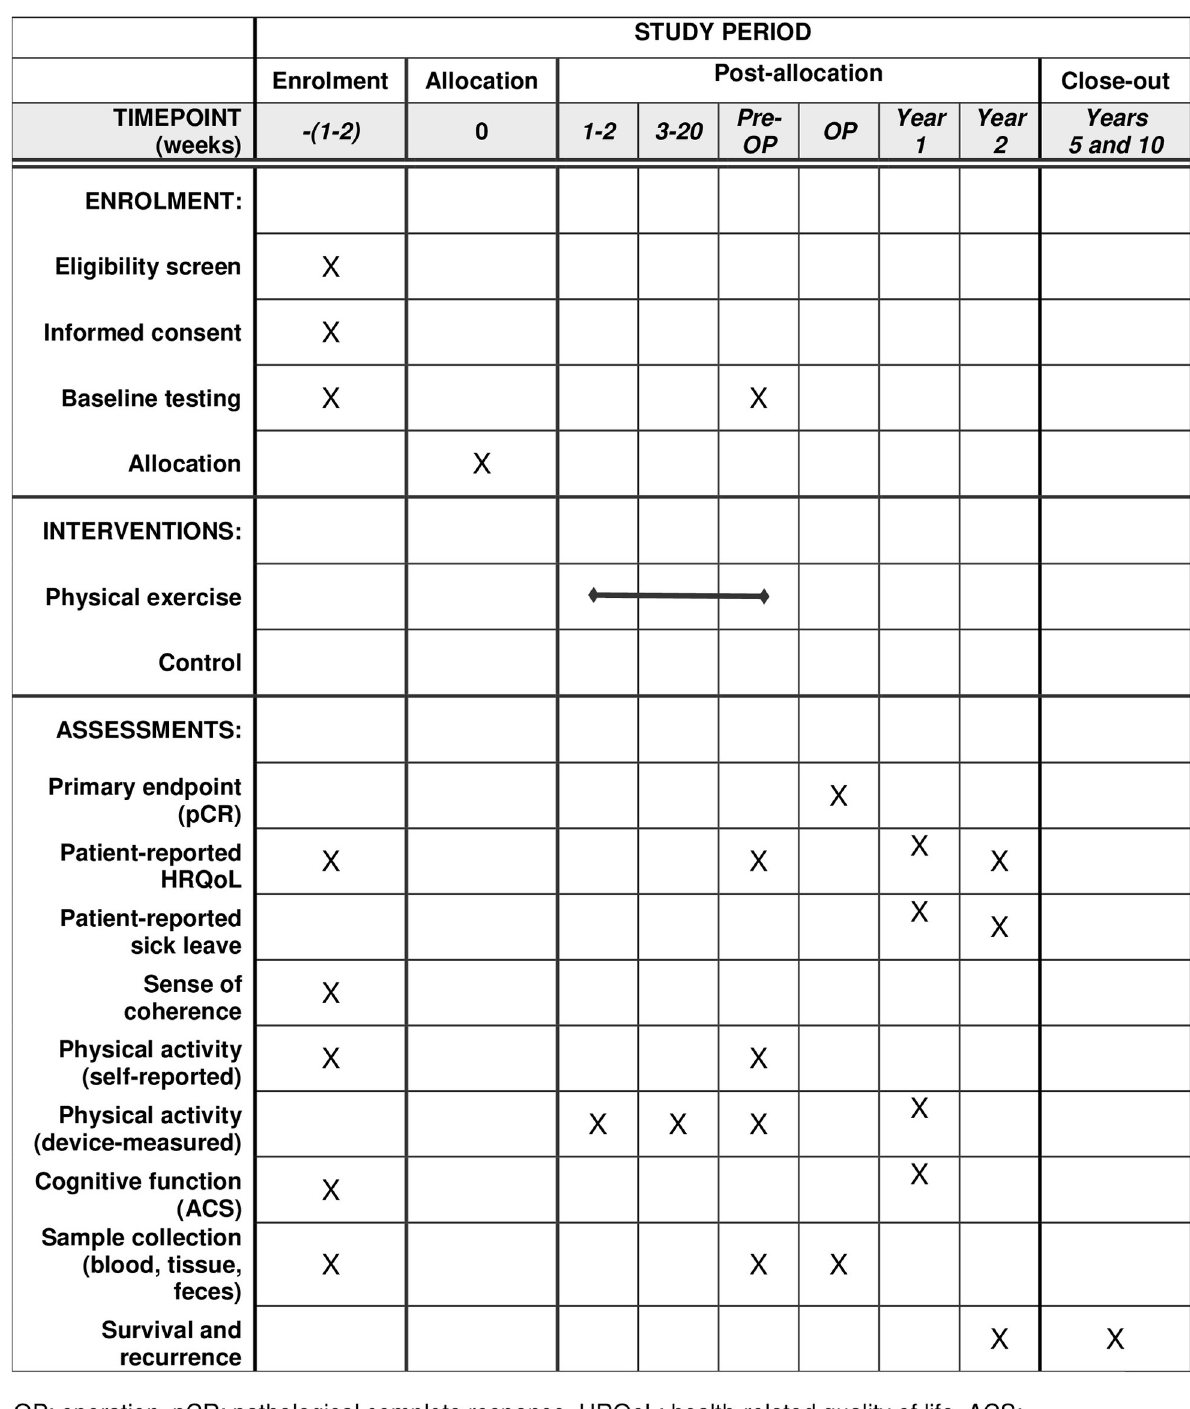
Fig 1. Schedule of enrolment, interventions, and assessments for the Neo-ACT trial.